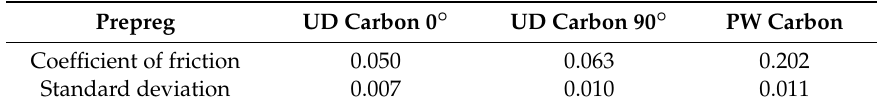
Table 5. Coefficient of friction of five different prepreg-prepreg patterns against our process parameters.